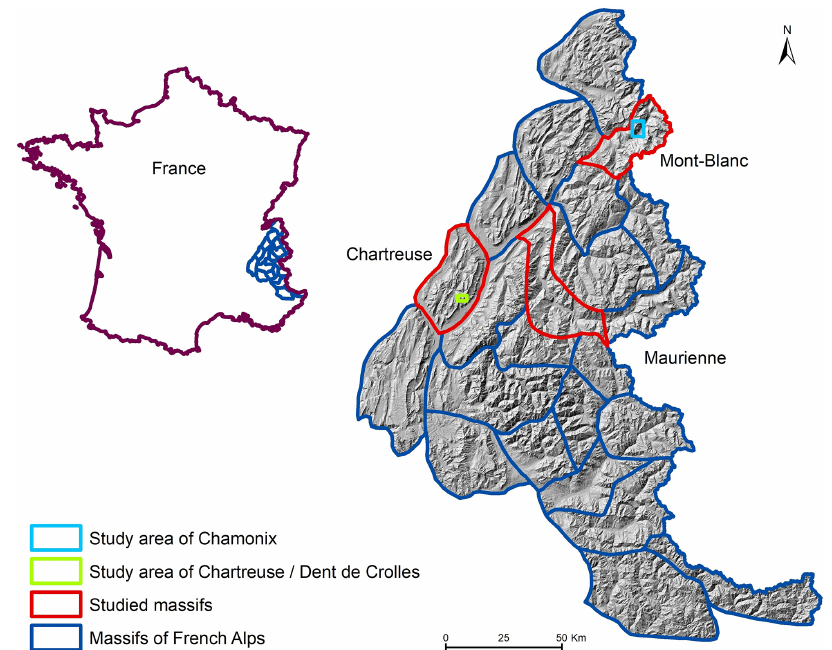
Figure 1. Study areas: three entire massifs (within the 23 massifs of the French Alps) and two small highlighted areas, the one of Chamonix and the one of Chartreuse/Dent de Crolles. Digital elevation model © IGN. Table 1. Characteristics of studied massifs and areas. For the PRA detection and the determination of the validation sample, all factors and the DEM resolution are set to their default values (Figs. 3–4), and forest cover data are from DB forest IGN. CLPA denotes the French avalanche cadastre; see Sect. 2.3 for more